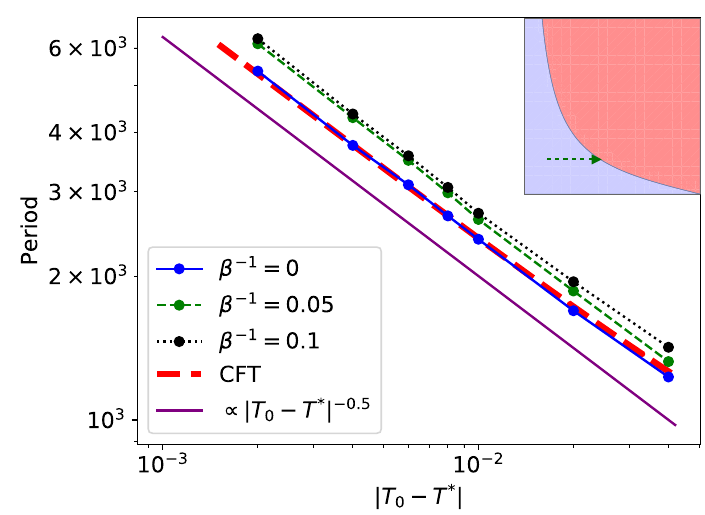
Figure 4: Scaling of the periodicity of total energy E ( t ) in the non-heating phase = T / L = 0.05, and for different when approaching phase transition at T ∗ , for T 1 0 initial states β − 1 . Explicit comparison with the CFT scaling (which is independent of temperature) is shown. While the periodicity changes as we increase initial tem- perature, its scaling near the phase transition agrees with the CFT prediction giving a critical exponent 1 for any initial 2